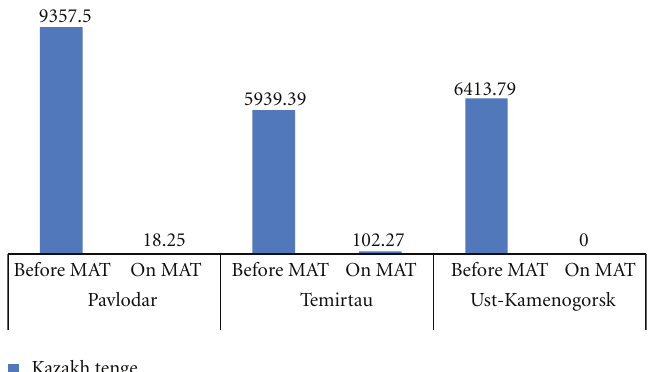
Figure 7: Mean daily expenditure in tenge for non-prescribed psychoactive substances by patients before and after enrollment in medication- assisted therapy, by